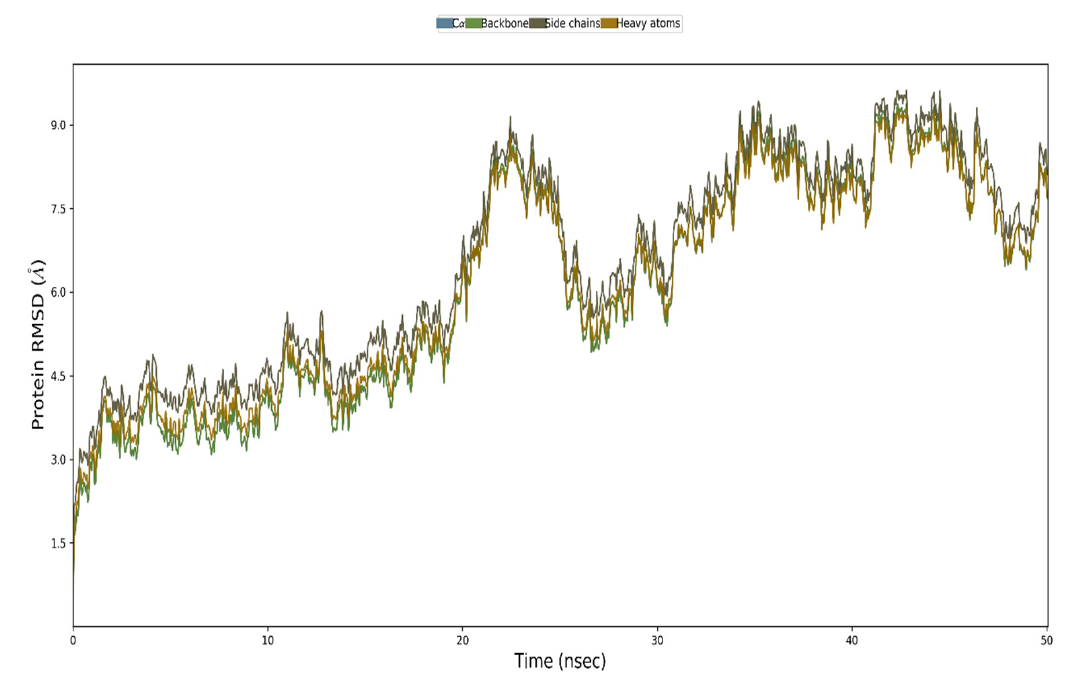
Figure 9. Modeling the multi-epitope vaccine complex at the molecular level. The backbone atoms of the complexes were seen using the RMSD method.